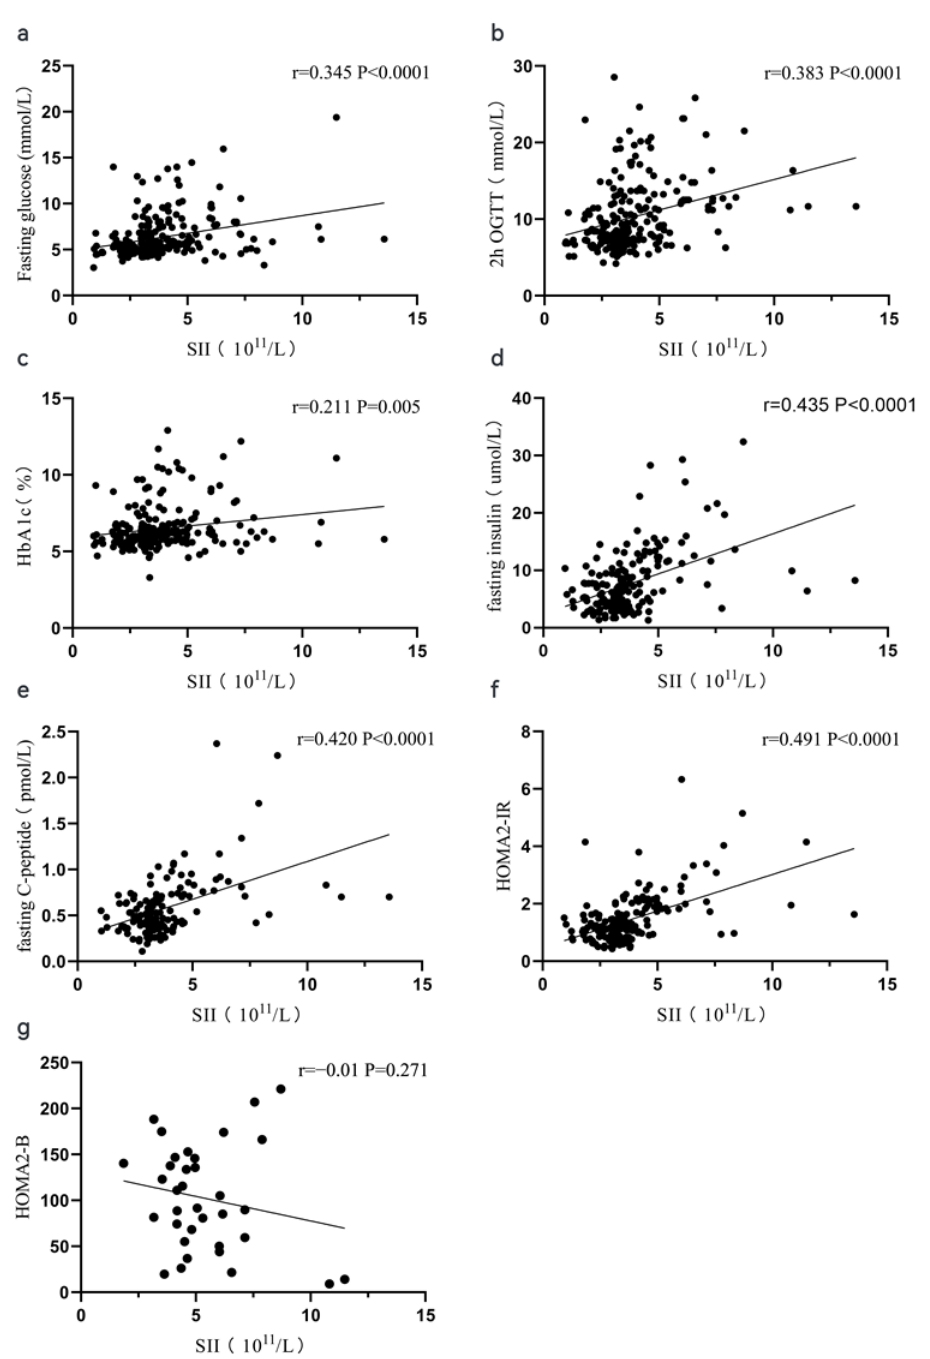
Figure 1. A scatter plot of the Spearman correlation analysis between SII and the glucose-related index. The correlation between SII and fasting glucose ( a ), 2 h OGTT ( b ), HbA1c ( c ), fasting insulin ( d ), fasting C-peptide ( e ), HOMA2-IR ( f ), and HOMA2-B ( g ).